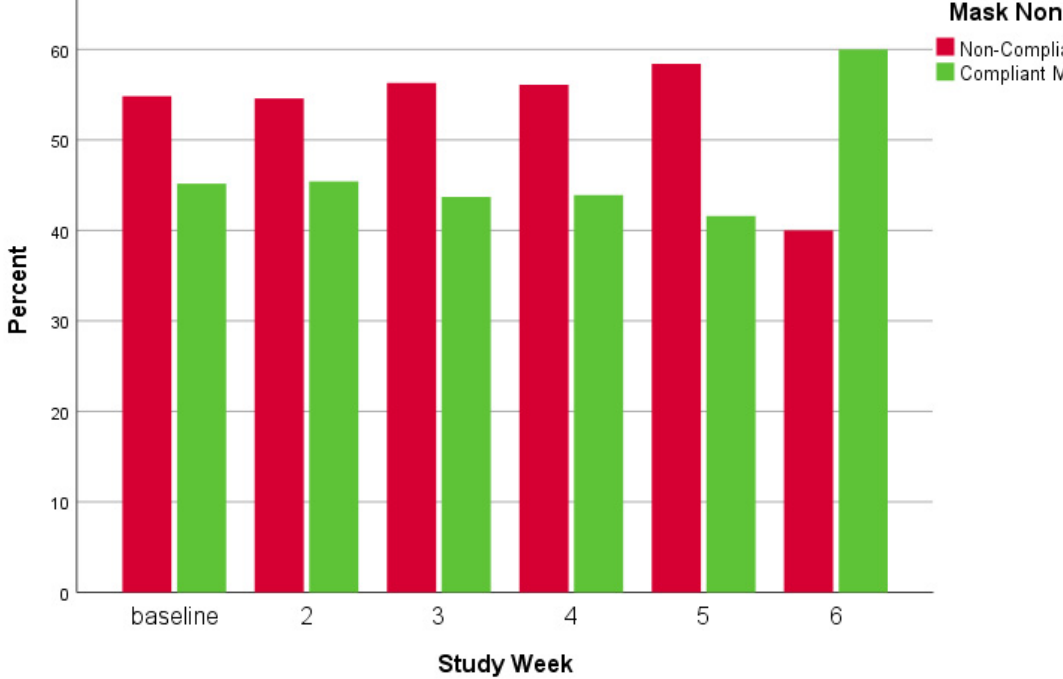
Figure 5. Mask wearing compliance by study week.